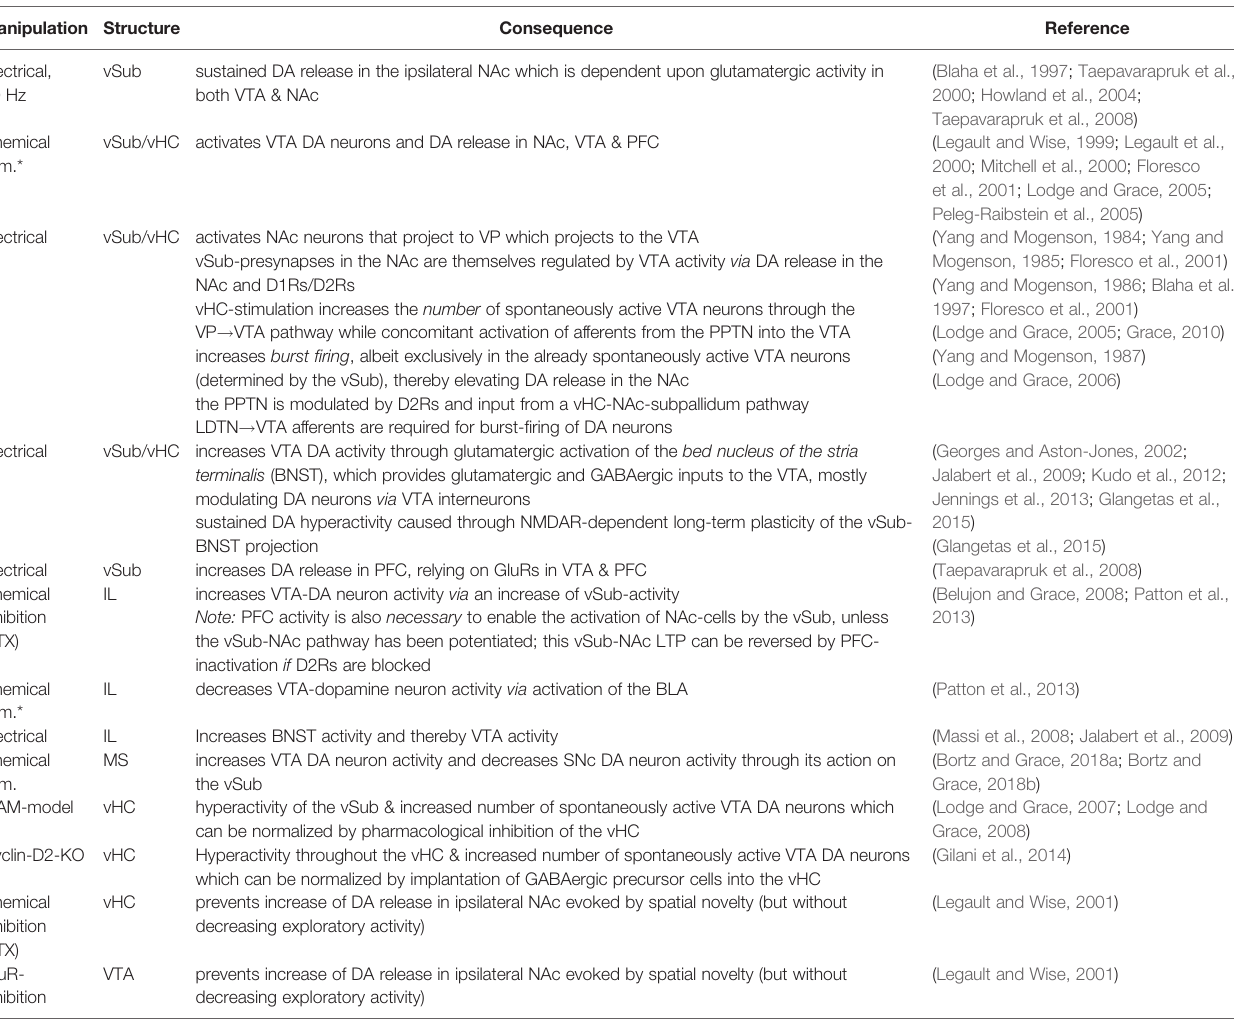
TABLE 1 | Experiments demonstrating the control of mesolimbic dopamine activity by the rodent ventral hippocampus and associated circuits. Manipulation